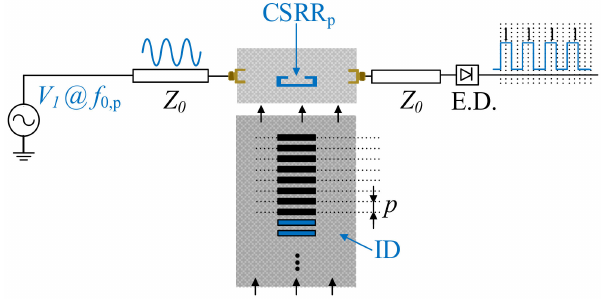
Figure 1. Sketch of the incremental electromagnetic encoder